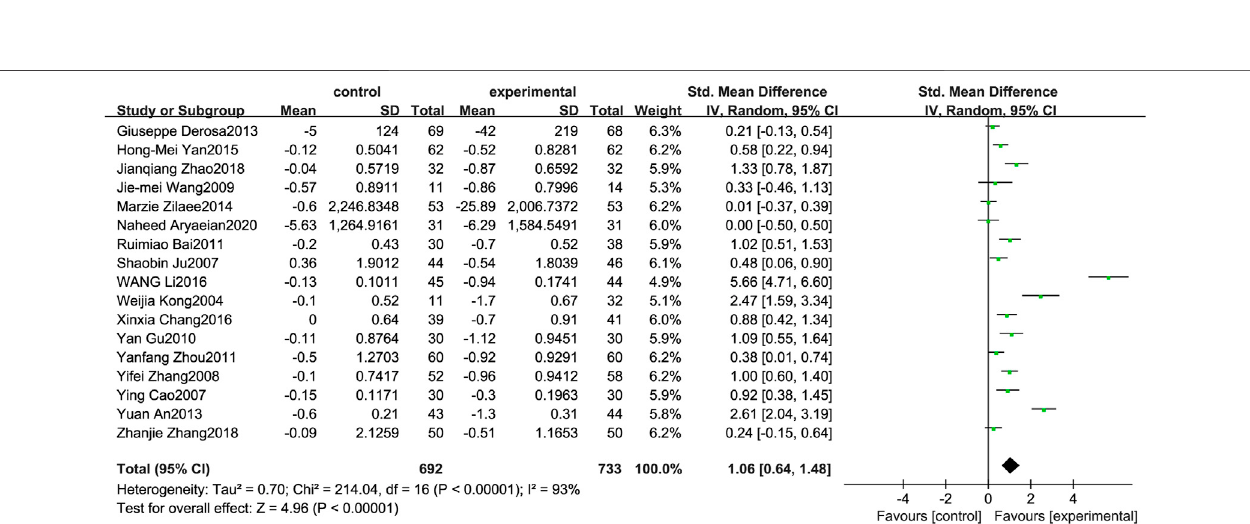
Frontiers in Pharmacology |